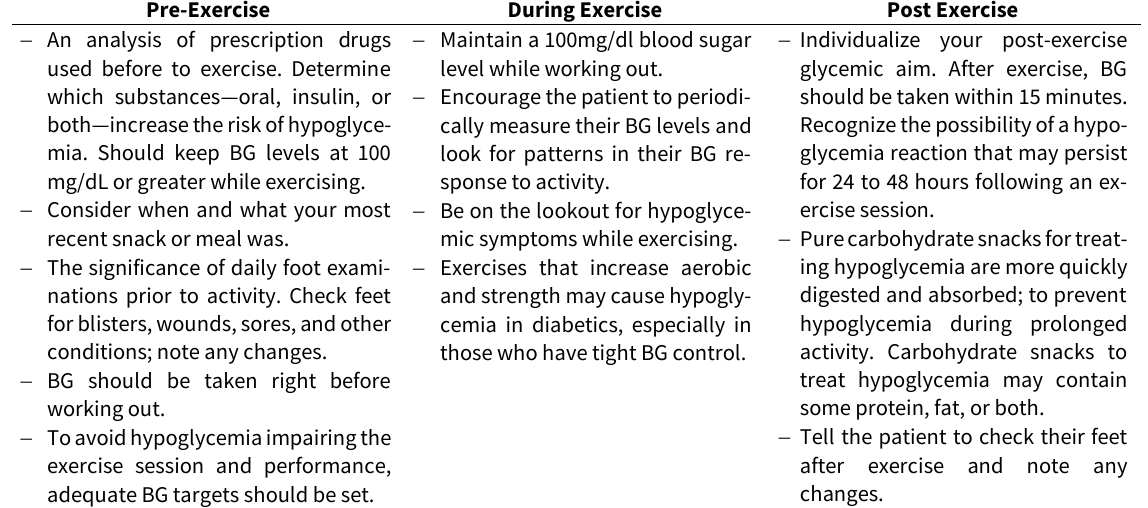
Table 1. Patient preparation of Cardiovascular Rehabilitation (5)